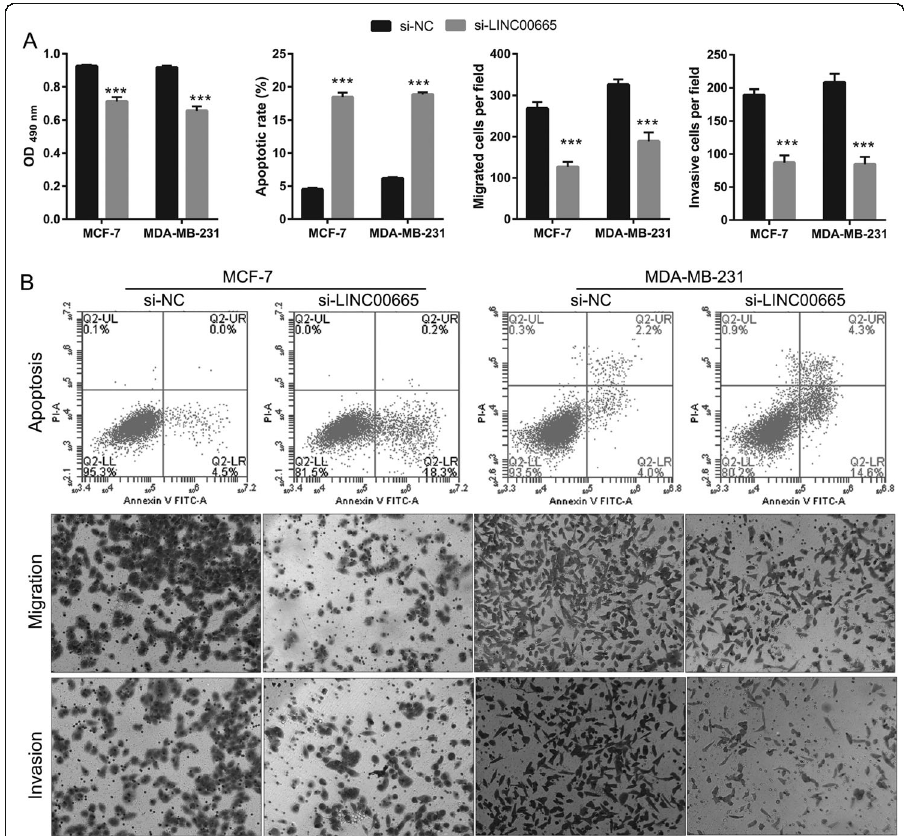
Fig. 3 LINC00665 knockdown inhibited breast cancer (BC) cell proliferation, migration, and invasion, but promoted apoptosis. a BC cell proliferation, apoptosis, migration, and invasion were measured by performing 3-(4,5-dimethylthiazol-2-yl)-2,5-diphenyltetrazolium bromide (MTT) assays, flow cytometry, transwell migration assays, and invasion assays, respectively. The data shown are the mean ± standard deviation (SD). b Representative images showing cell apoptosis, migration, and invasion. *** P <